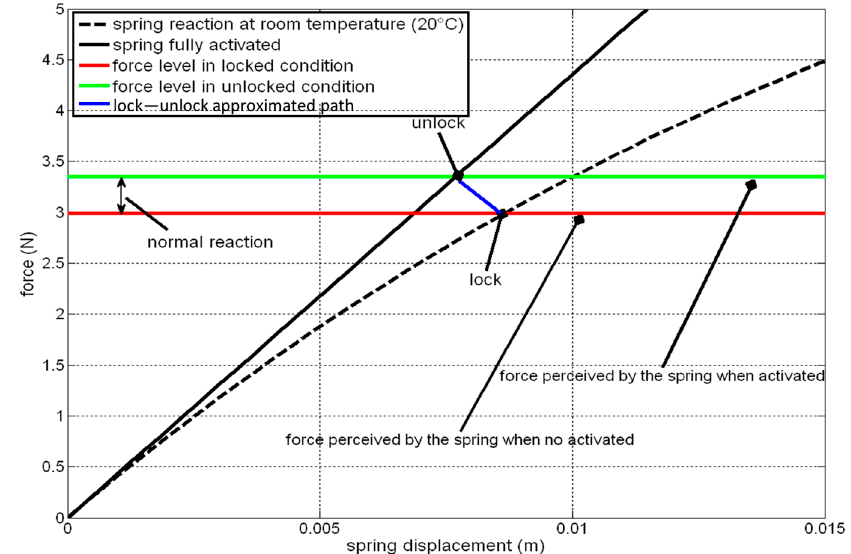
Figure 9. Force-displacement curves for the springs of the locking subsystem: room temperature (black dashed line), full austenite (black solid line), force level including the normal reaction (red line—locked condition), force level without contact (green line—unlocked condition, spring fully activated), lock—unlock approximated path (blue line).